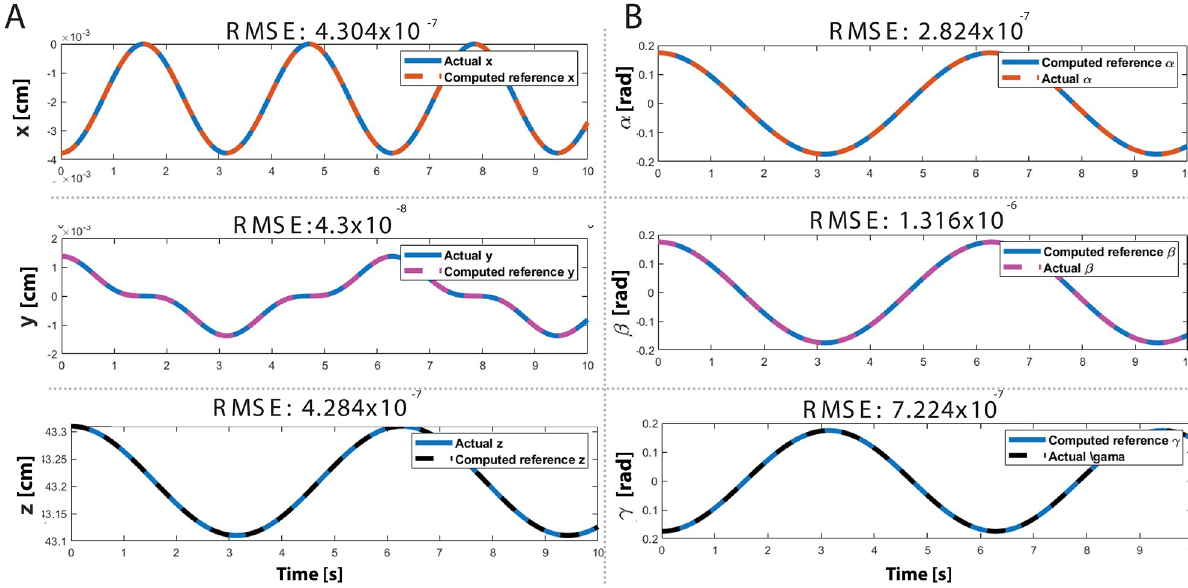
Fig 8. Simulation results (A) Translational motion of the end-effector (B) Rotational motion of the end-effector.